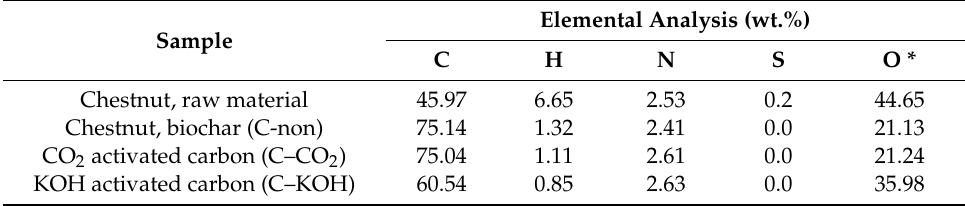
Table 1. Elemental analysis of the raw chestnut, biochar after pyrolysis and activated carbons. Elemental Analysis (wt.%) Sample C H N S O * Chestnut, raw